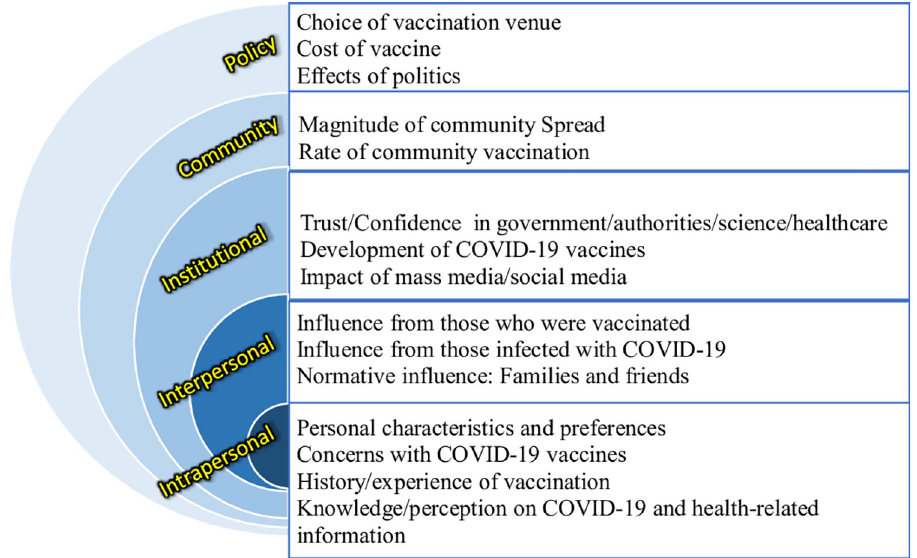
Fig 2. Summary of factors/themes in the social ecological